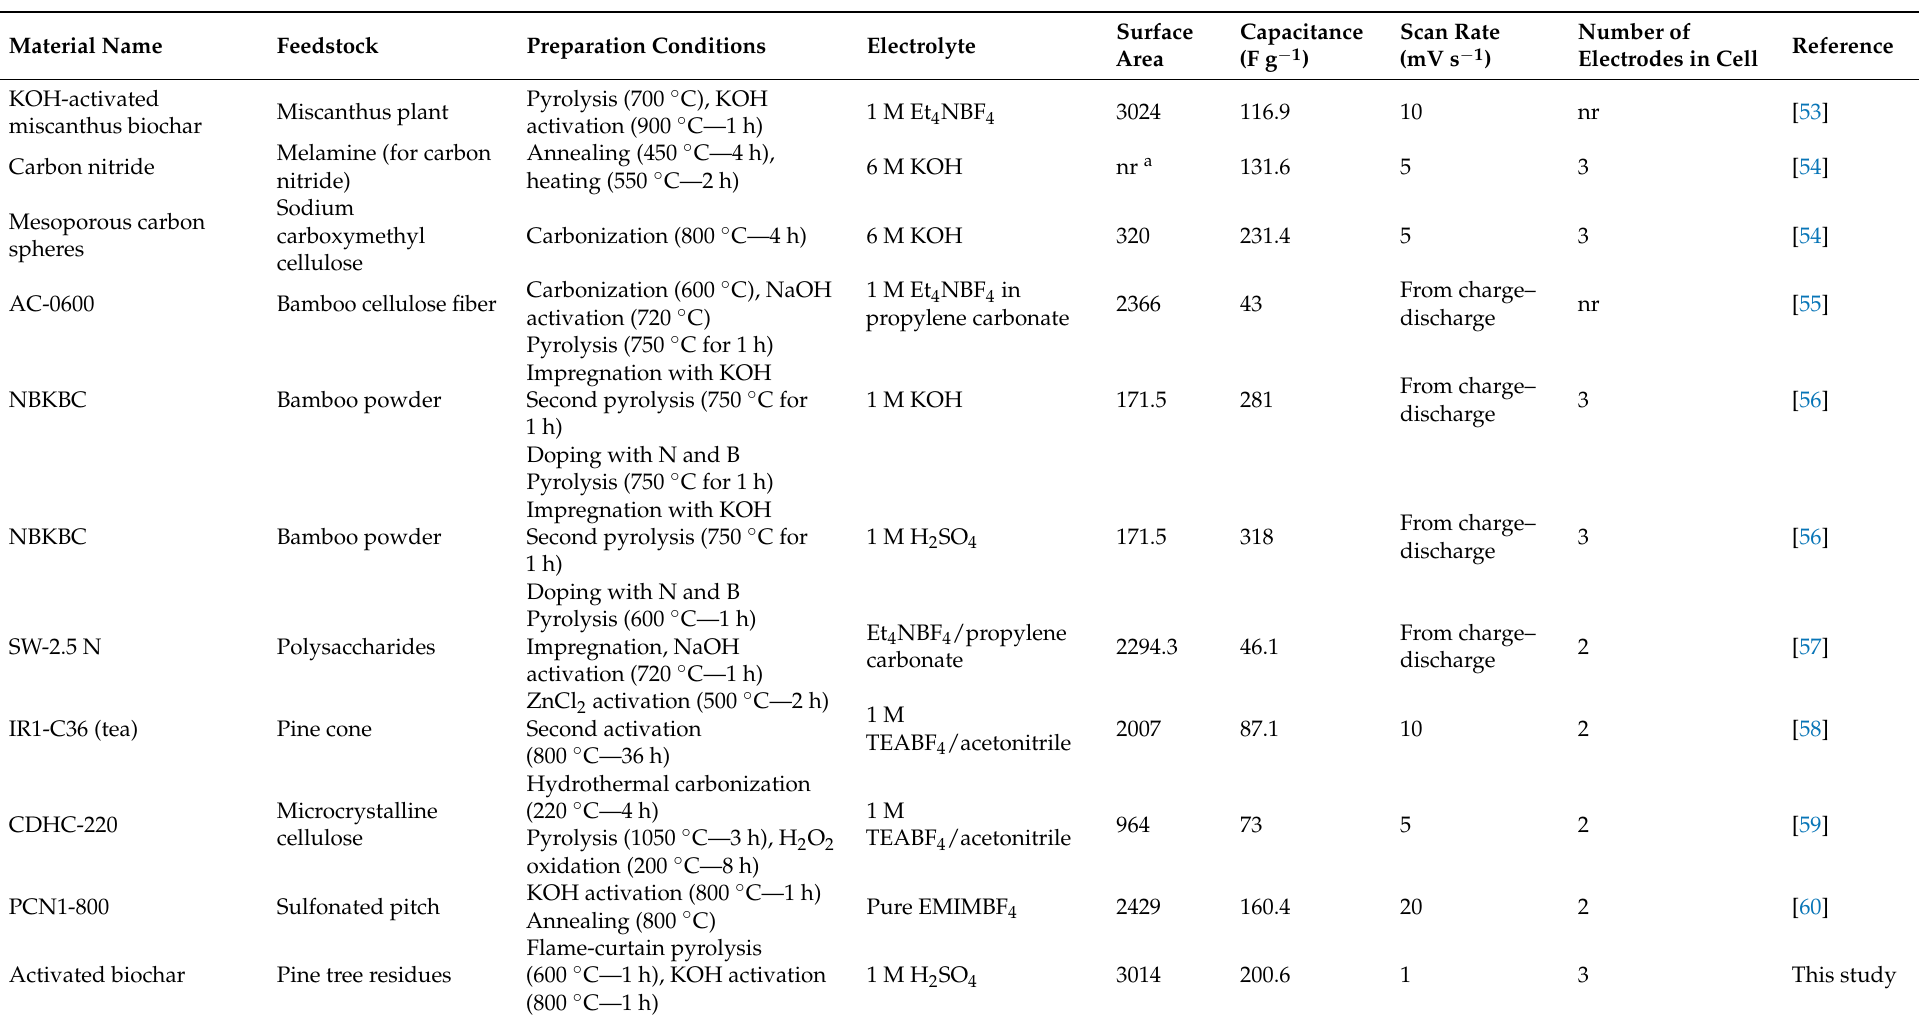
Table 5. Comparison of activated biochar developed in this study to previously reported materials (nr a : not